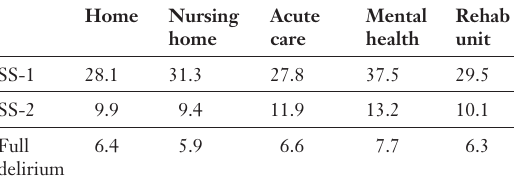
Prevalence in % of sub-syndromal and full-blown delirium in nursing homes stratified according to previous resi- dence.